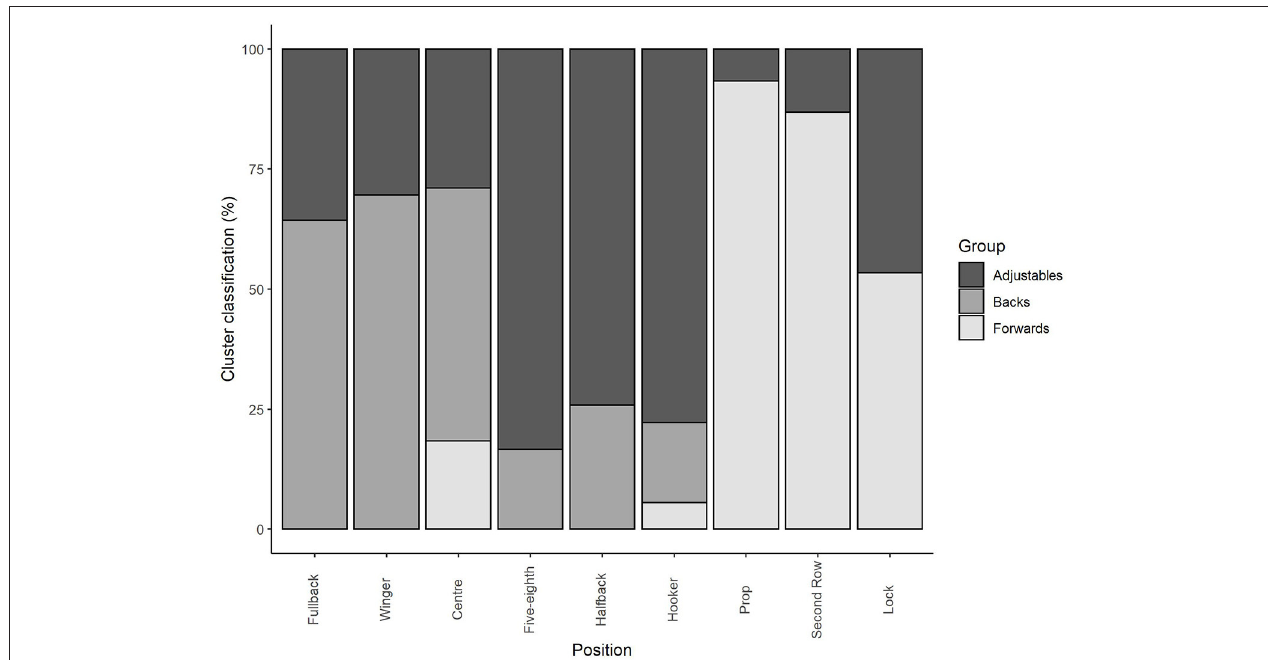
FIGURE 1 | Cluster classification of positional groups.